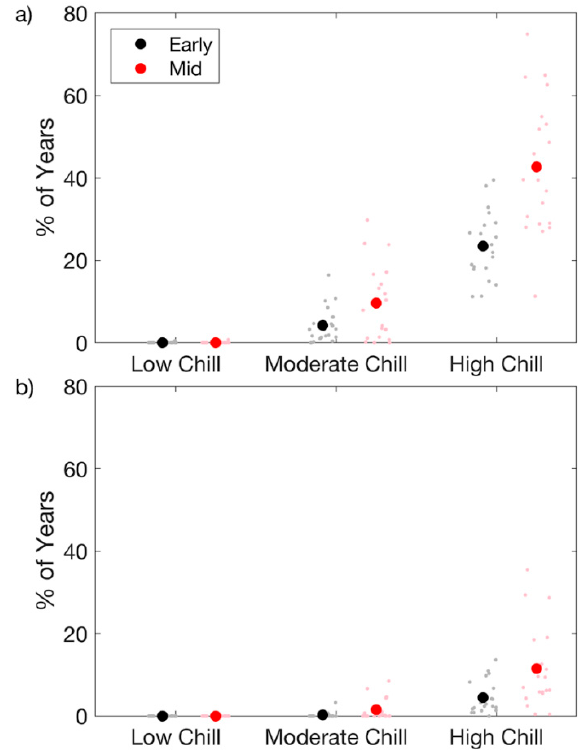
Figure 5. ( a ) For the Georgia peach-growing region, the percent of years with insufficient chill for a low-, moderate-, and high-chill peach cultivar under early 21st (black/grey) and mid-21st (red/pink) century conditions. Small grey and pink dots indicate the percent years for individual models, while the larger black and red dots indicate the 20-model average ( b ) As in ( a ) but for the South Carolina peach-growing region.